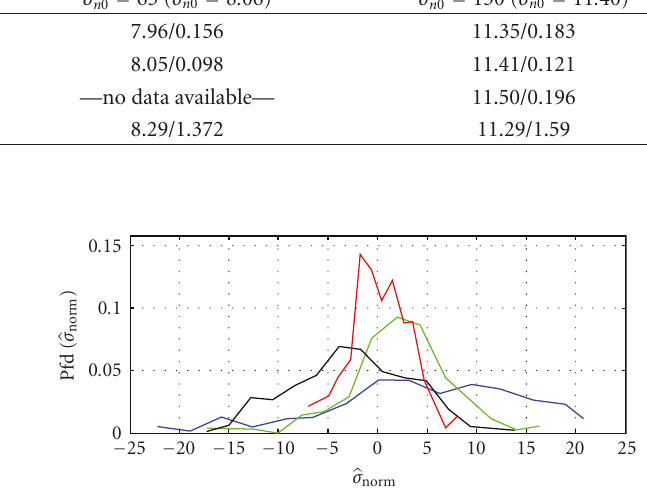
Table 1: Mean and STD of additive noise STD estimates (cid:19) σ c for TID2008 database. Mean( (cid:19) σ c )/STD( (cid:19) σ c )